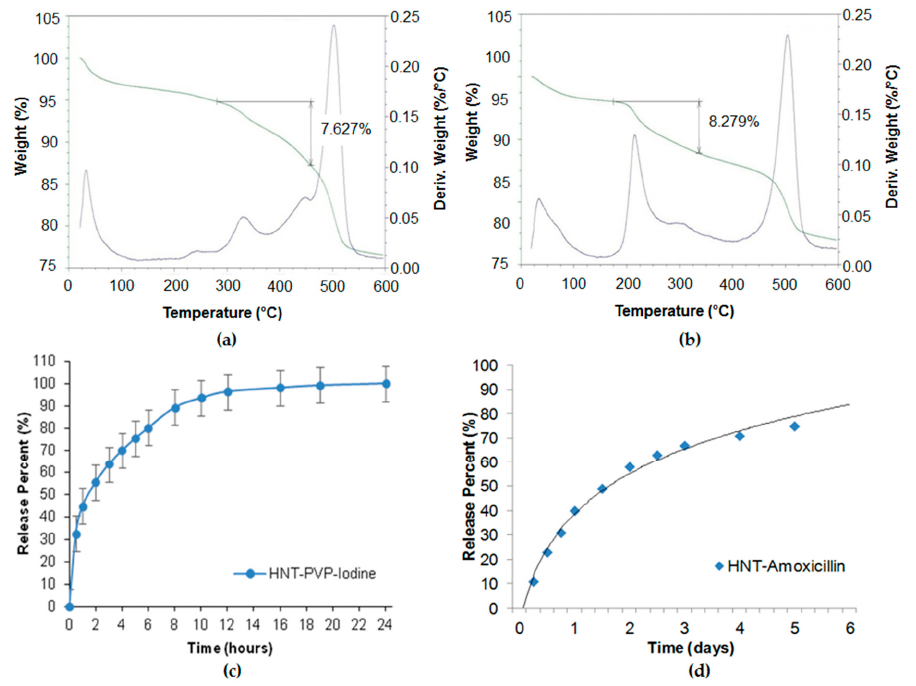
Figure 4. Thermogravimetric analysis (TGA) profiles of ( a ) povidone-iodine and ( b ) amoxicillin in halloysite, showing 7.6 and 8.3 wt % loading. Sustained release profiles of ( c ) povidone iodine and ( d ) amoxicillin from halloysite clay.